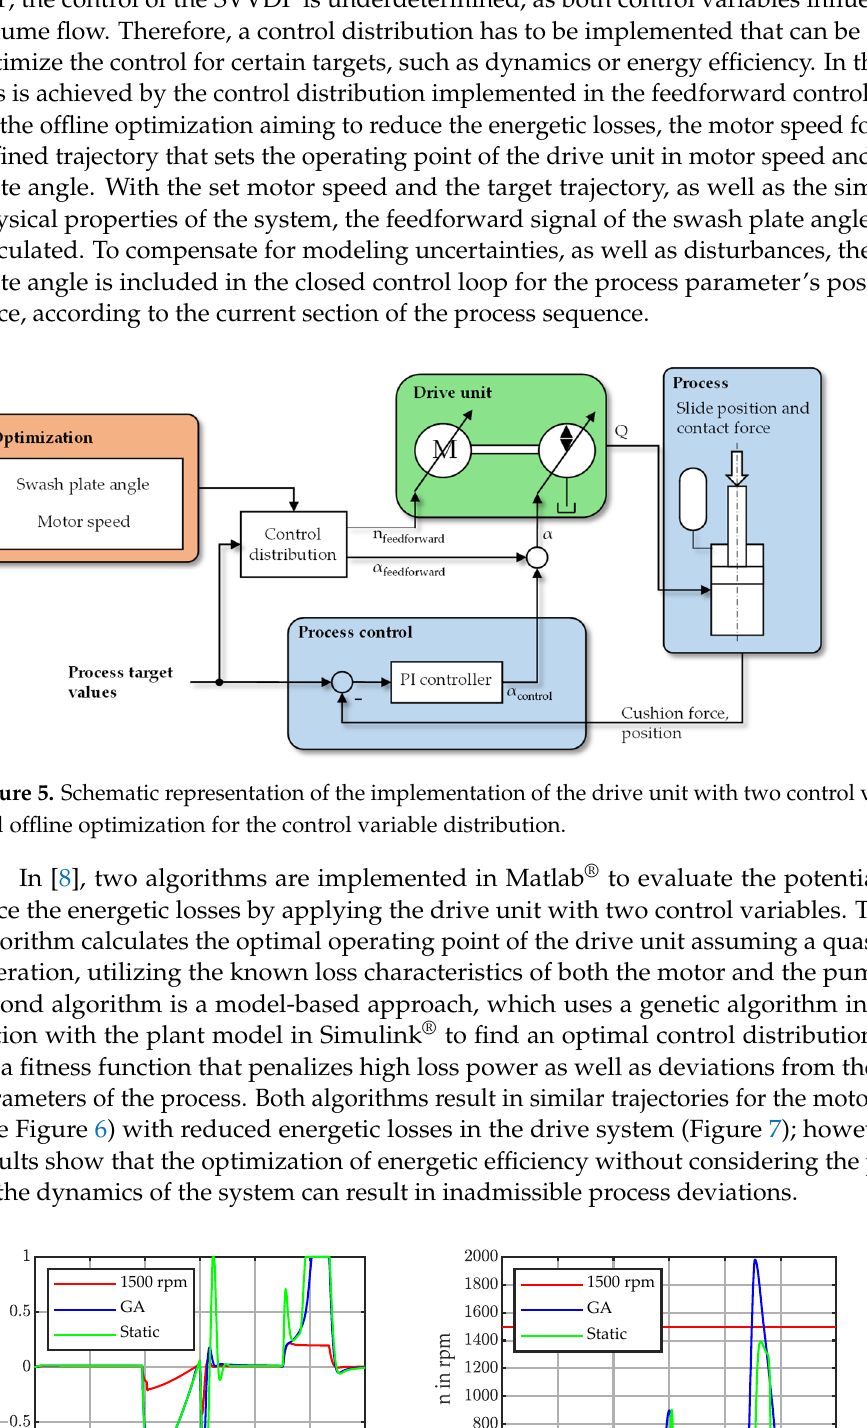
Figure 6. Left: motor speed trajectories generated by the optimization algorithms; right: resulting swash plate angles during the sequence.